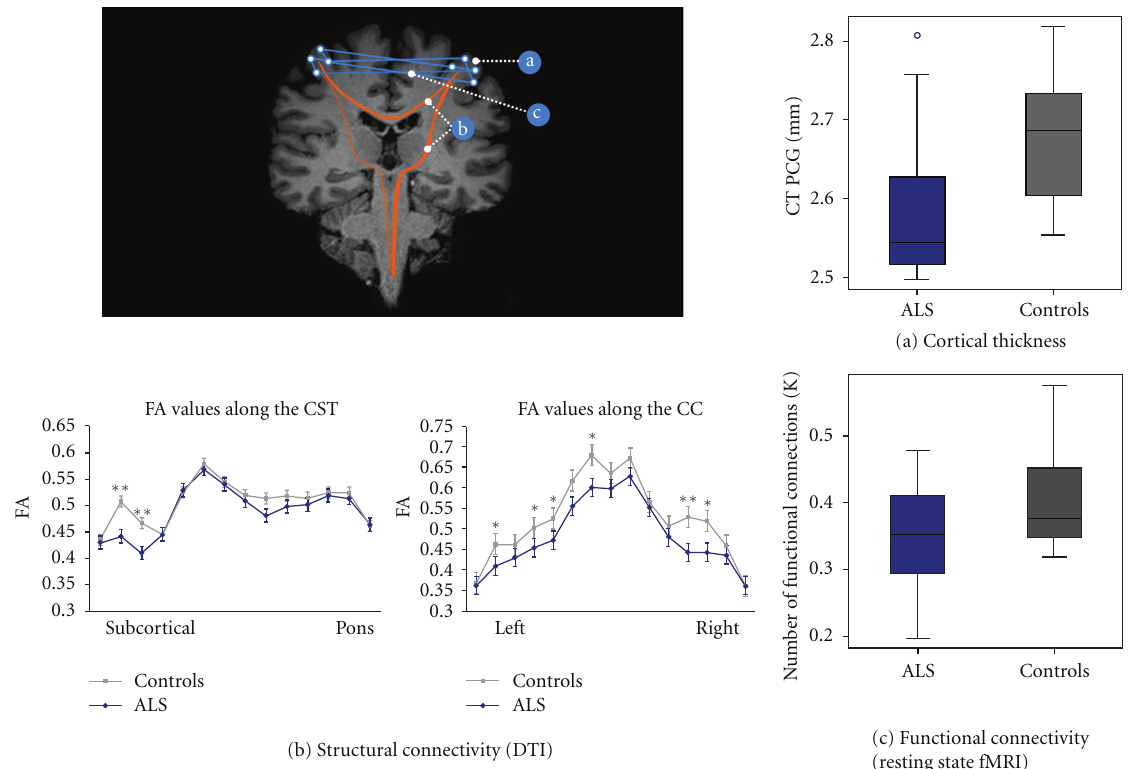
Figure 3: (a) Cortical thickness (CT) in patients with ALS versus controls in the preCG in mm ( P = 0 . 04), corrected for age and whole brain CT. (b) Fractional anisotropy (FA) values along the CST and the corpus callosum, evaluated by DTI analysis, in patients with ALS and controls ( ∗∗ P < 0 . 01; ∗ P < 0 . 05). (c) Number of functional connections in patients with ALS versus controls, corrected for age (threshold 0.40) ( P = 0 . 14): this result was indicative of a relative sparing of functional connectivity in patients (derived from Verstraete et al.